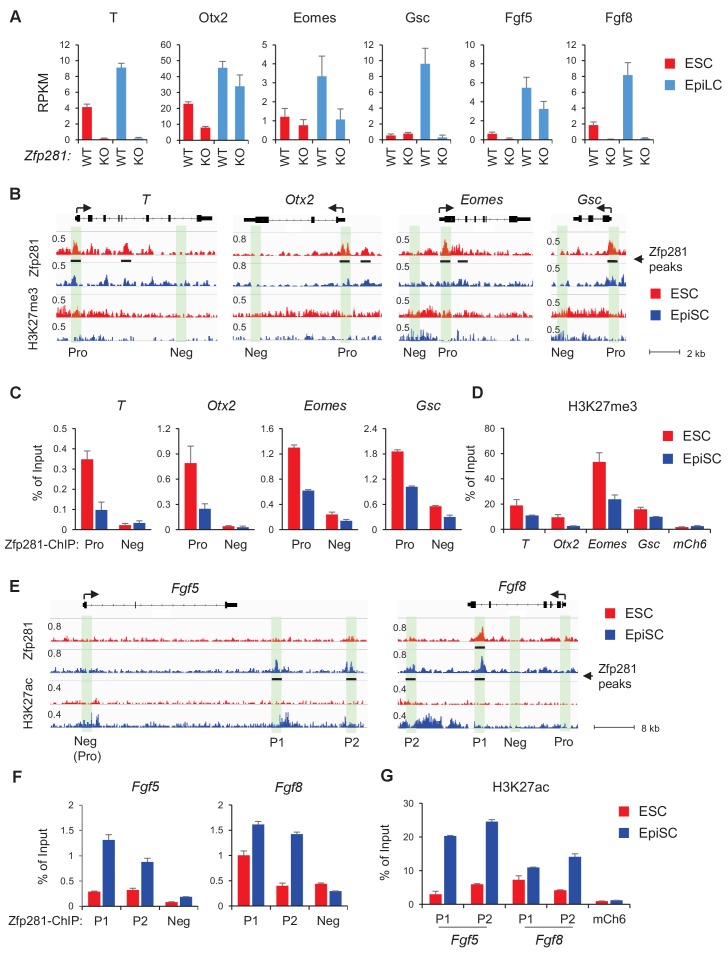
Zfp281 activates lineage-specific genes during epiblast maturation.(A) Expressions of lineage-specific genes in WT and Zfp281KO ESCs and EpiLCs, from a previous published RNA-seq dataset (Fidalgo et al., 2016). mRNA expression level is mapped reads per million total mapped reads per kilobase (RPKM). (B) Zfp281 and H3K27me3 ChIP-seq tracks at loci of T, Otx2, Eomes, and Gsc. Black bar under track indicates region called as Zfp281 peak by MACS software. (C) ChIP-qPCR of Zfp281 at promoters (Pro) of T, Otx2, Eomes, and Gsc in ESCs and EpiSCs. Promoter and negative regions for PCR at each gene are shown in panel B. (D) ChIP-qPCR of H3K27me3 at promoters of T, Otx2, Eomes, and Gsc. mCh6 is a negative control mapping to a gene desert region on chromosome 6 (Boyer et al., 2006). (E) Zfp281 and H3K27ac ChIP-seq tracks at loci of Fgf5 and Fgf8. Black bar under track indicates region called as Zfp281 peak by MACS software. (F) ChIP-qPCR of Zfp281 at regulatory regions of Fgf5 and Fgf8 in ESCs and EpiSCs. Positions for PCR at each gene are shown in panel E. (G) ChIP-qPCR of H3K27me3 at regulatory regions of Fgf5 and Fgf8. mCh6 is a negative control mapping to a gene desert region on chromosome 6 (Boyer et al., 2006). ChIP-qPCR primer sequences are provided in Figure 5—source data 1.10.7554/eLife.33333.021Figure 5—source data 1.ChIP-qPCR primer sequences.